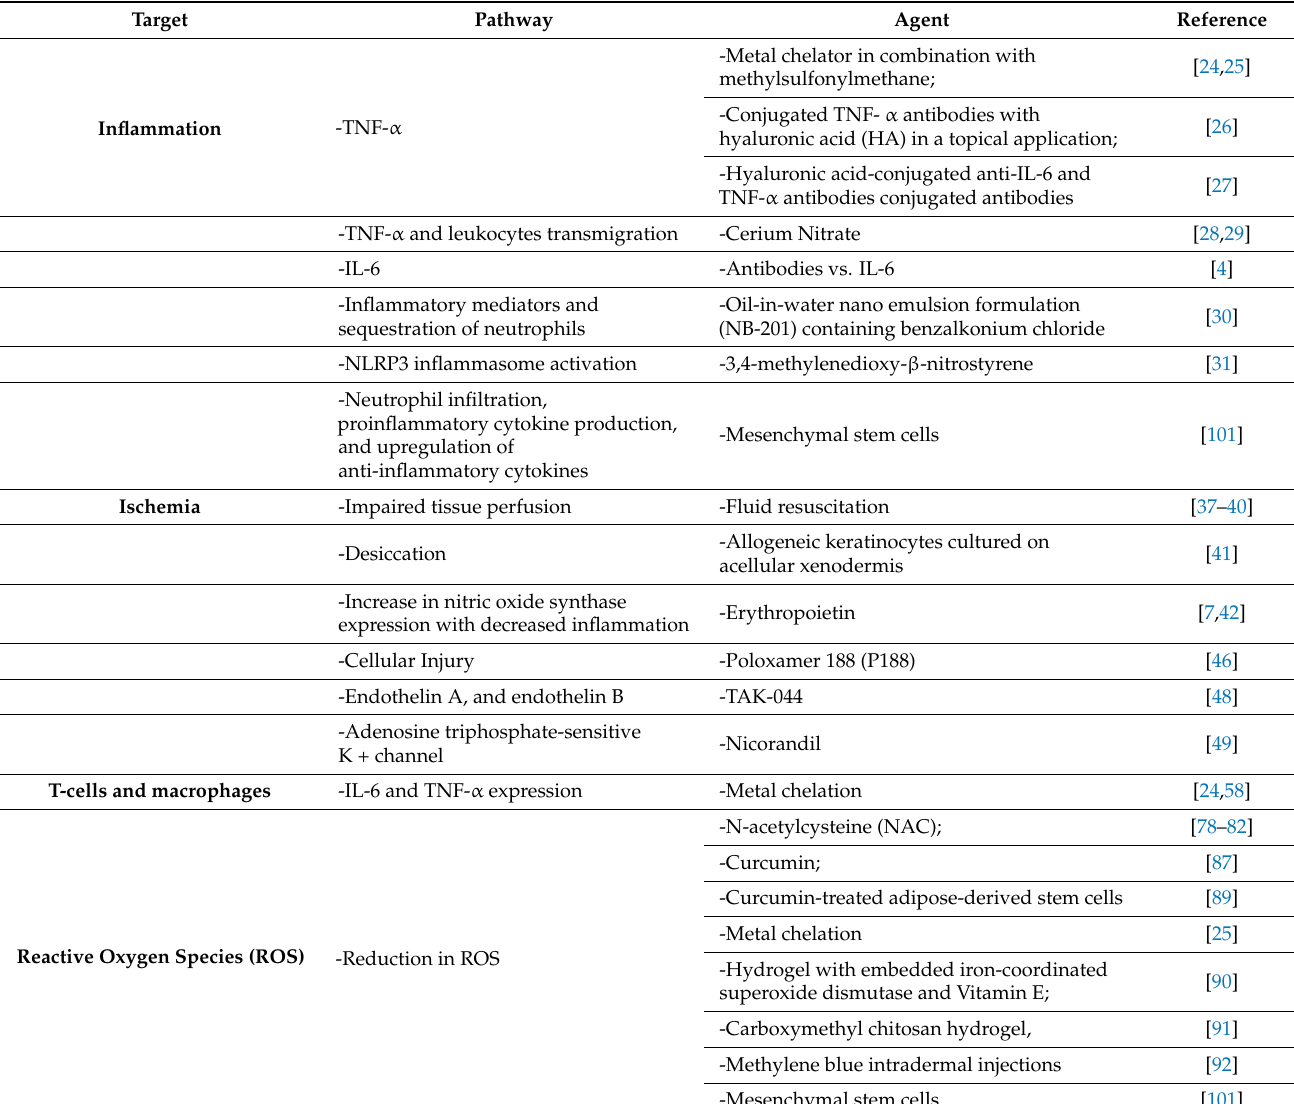
Table 1. Therapeutic approaches targeting various mechanisms of burn wound